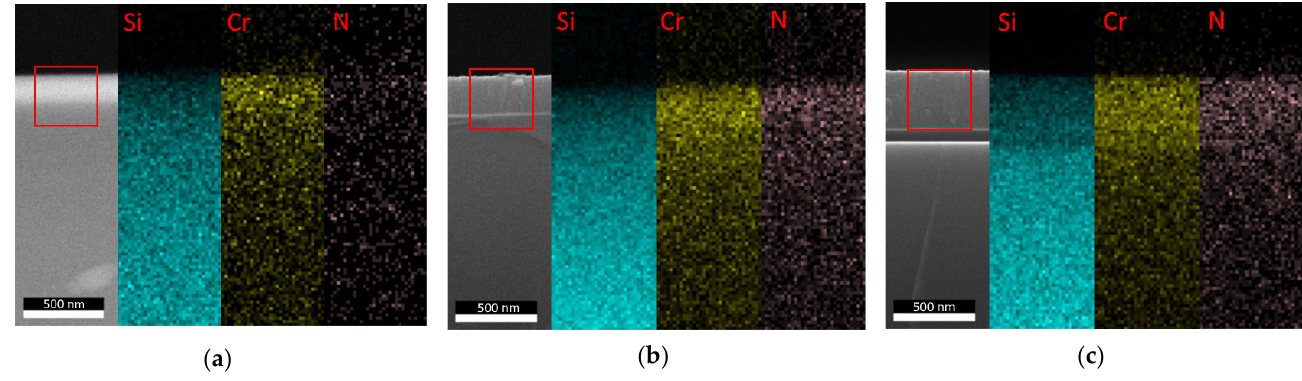
Figure 2. EDAX elemental mapping showing the distribution of chemical elements using the DC power supply for the deposition times of ( a ) 5 min, ( b ) 10 min, and ( c ) 15 min.